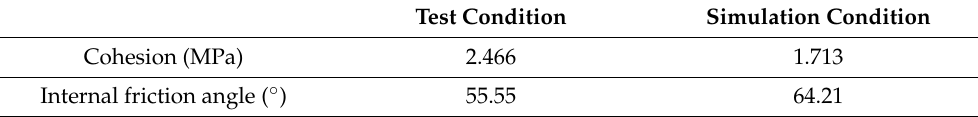
Table 2. Shear mechanical parameters under test and simulation conditions.